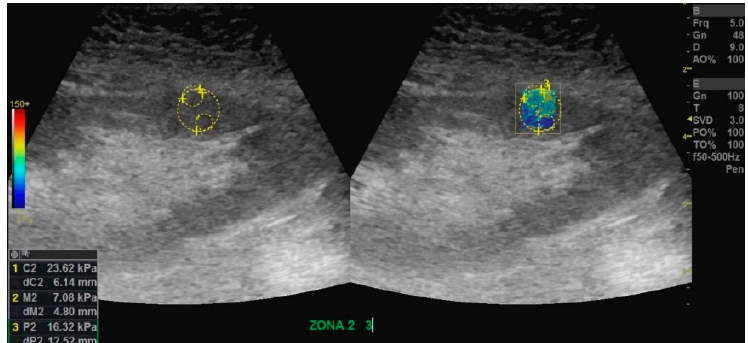
Figure 2. Image from shear-wave elastography shows measurements of stable function kidney allograft on an overweight woman, age 55 years at transplant, examined at two years post-transplant. The image in the left illustrates the renal cortex ROI (1), renal medulla ROI (2), and overall ROI (incorporating renal cortex and medulla, (3). An elastogram box filling with heterogeneous color distribution in the range of low and medium stiffness is observed in the right image (the blue color indicates shiftiness while the red pattern suggests an increased rigidity).